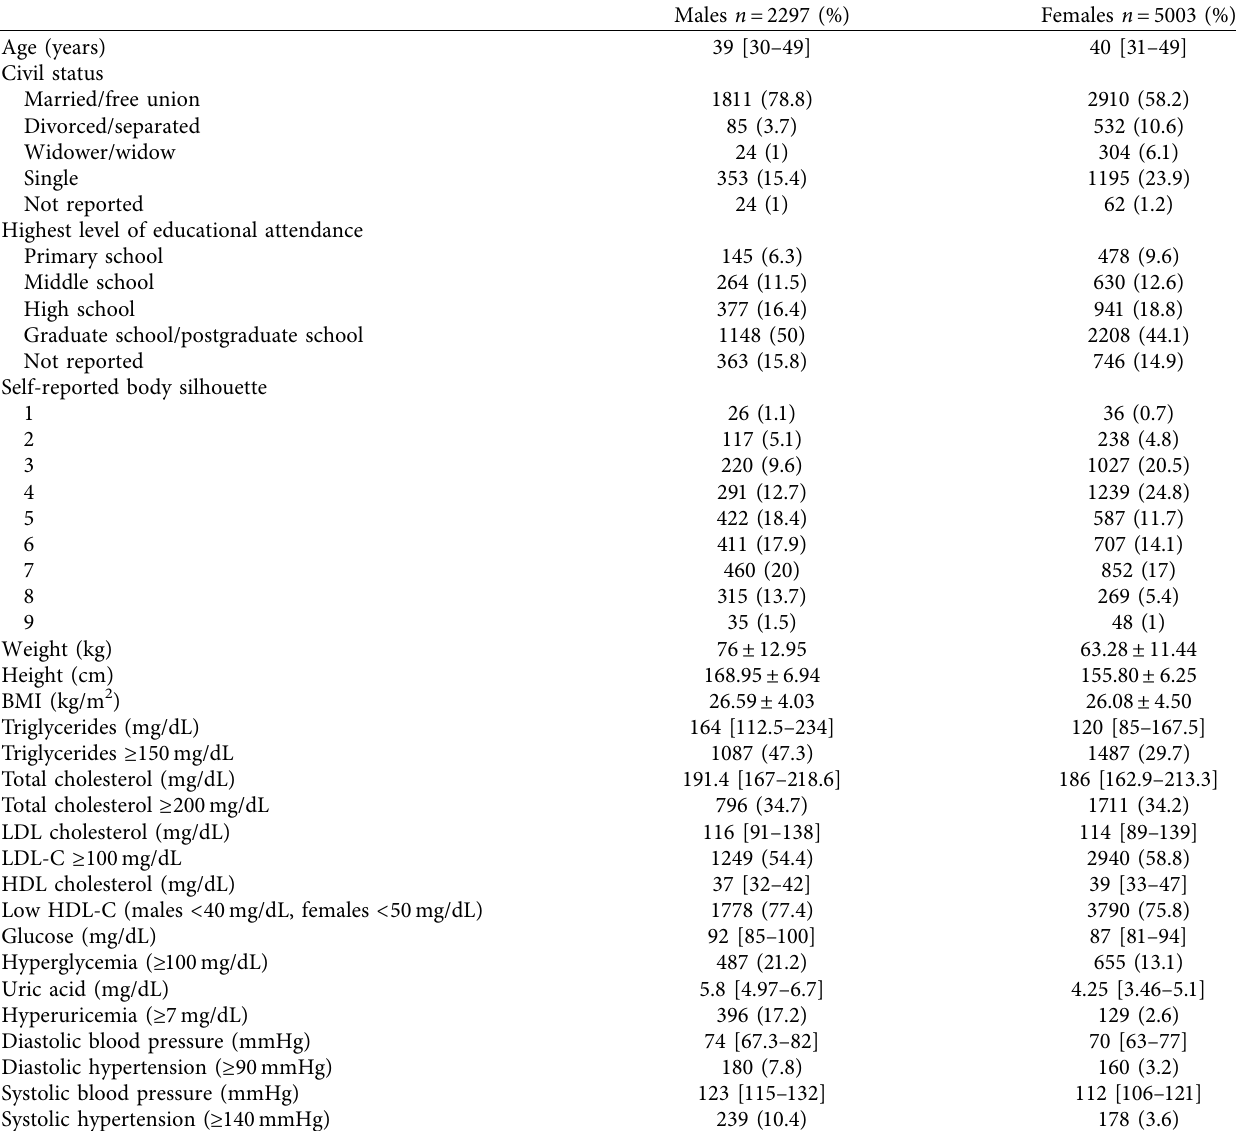
Table 1: Clinical and demographic characteristics of the studied